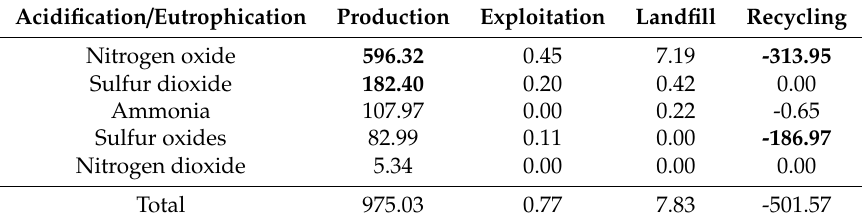
Table 11. Results of grouping and weighting of environmental after-e ff ects for acidifying / eutrophication compounds, occurring in the life cycle of 1 megawatt photovoltaic power plant [unit: Pt].